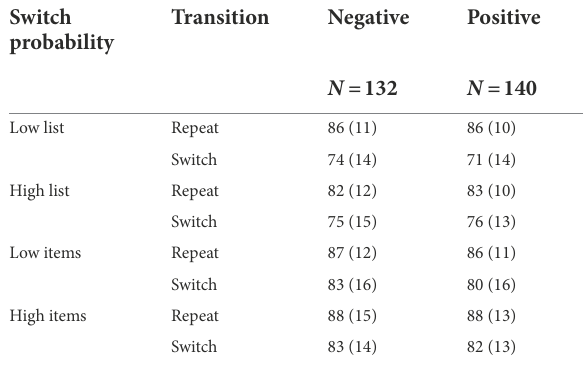
TABLE 1 Mean response times (ms) with standard deviations in Experiment 1 as a function of background valence, switch probability, and transition.